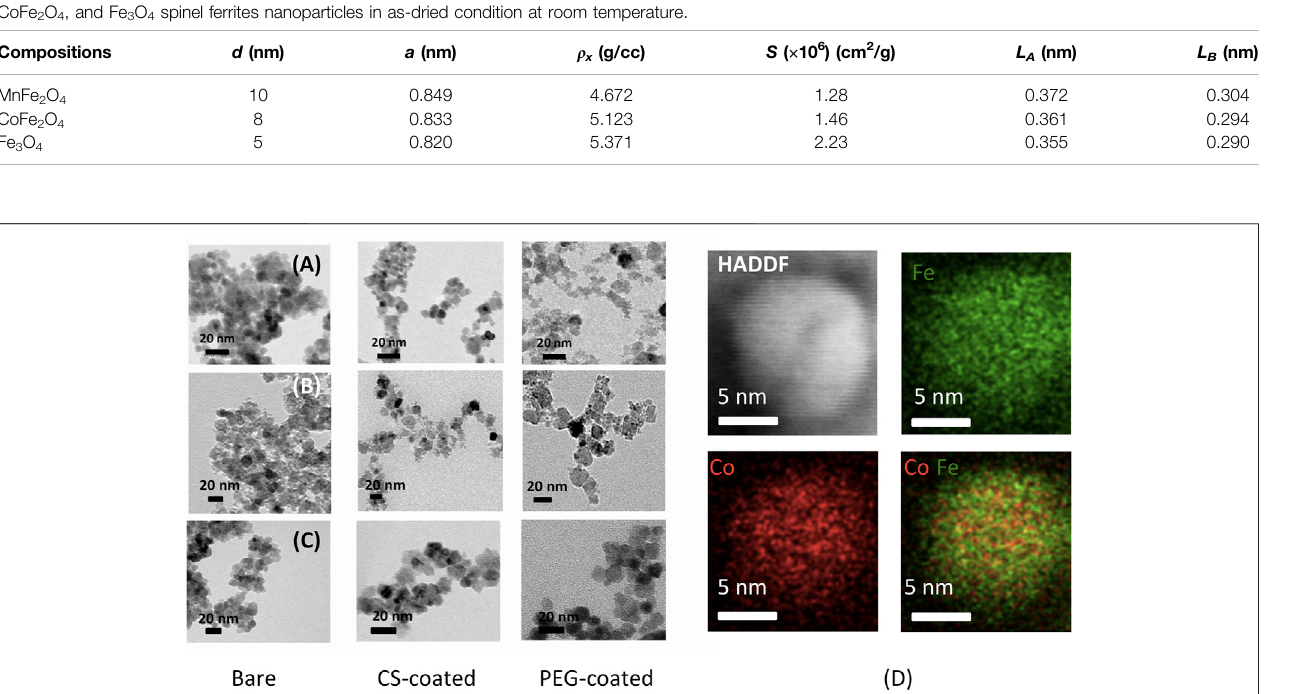
Frontiers in Nanotechnology |